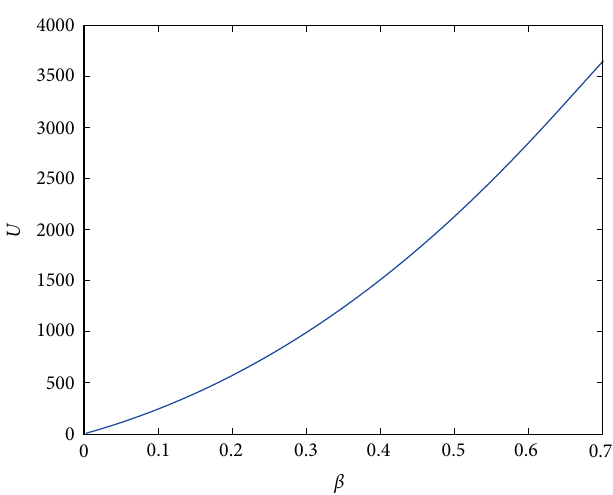
Figure 3: Relationship between 𝑈 and 𝛽